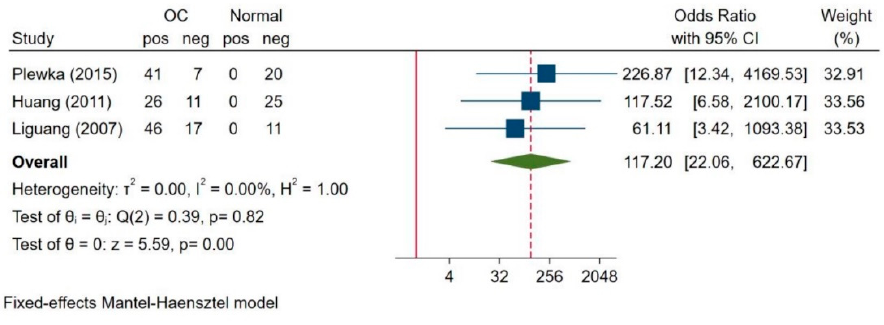
Figure 2. Comparison of survivin expression between ovarian carcinoma and ovarian normal tissue [33,36,37]. Abbreviations: OC = Ovarian Cancer.